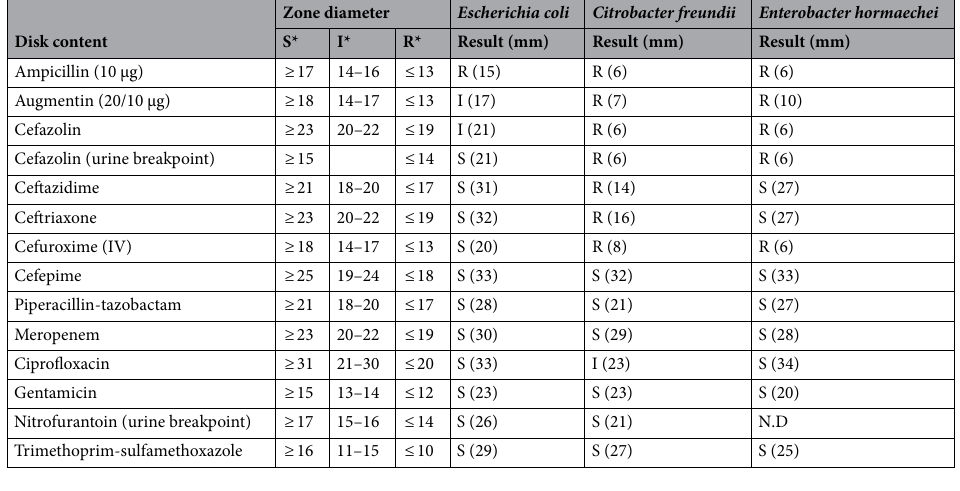
Table 1. Antibiotic susceptibility by disk diffusion of normal colony variant for each isolate based on CLSI M100-S29 breakpoints. *"S" sensitive, "I" intermediate, and "R"